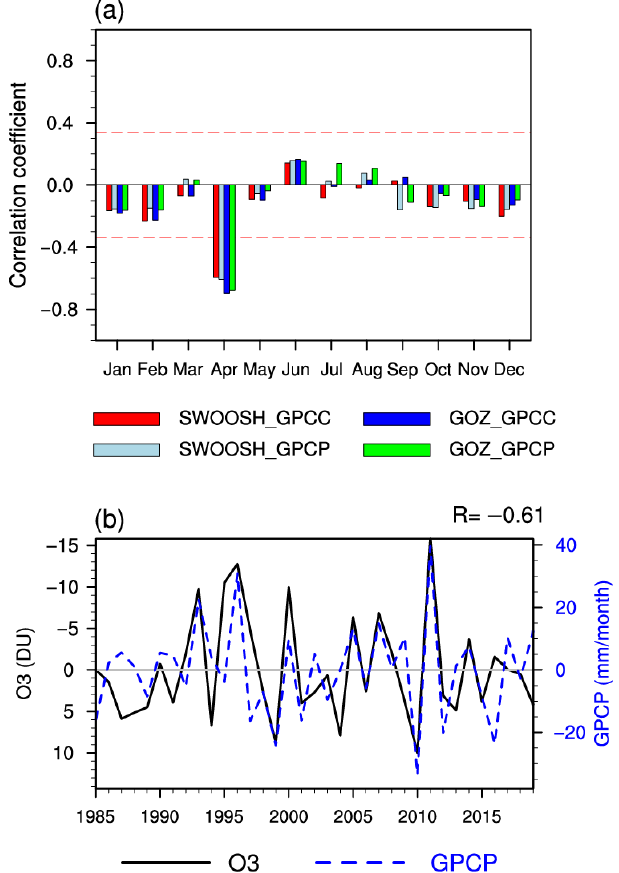
Figure 2. ( a ) Correlation coefficients between March ASO index and precipitation anomalies over eastern North America (38 – 54°N, 65 – 87°W) for individual months (January – December of the same year), calculated using different ozone and precipitation datasets for the period 1985 – 2019 (SWOOSH). We note that the GOZCARDS ozone data span the period 1985–2012. Red lines denote correlation coefficients that are significant at the 95% confidence level. ( b ) Time series of March ASO index and regionally averaged April rainfall anomalies after removal of seasonal cycles and linear trends. The correlation coefficient between the two time series is given in the upper-right corner. ASO data are derived from SWOOSH and rainfall from GPCP.